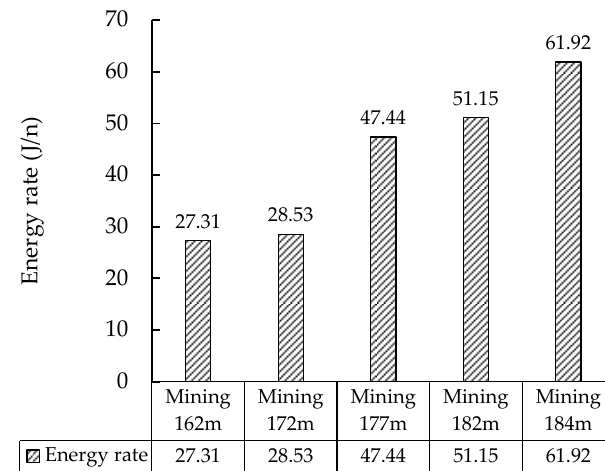
Figure 15. MS energy release rate.